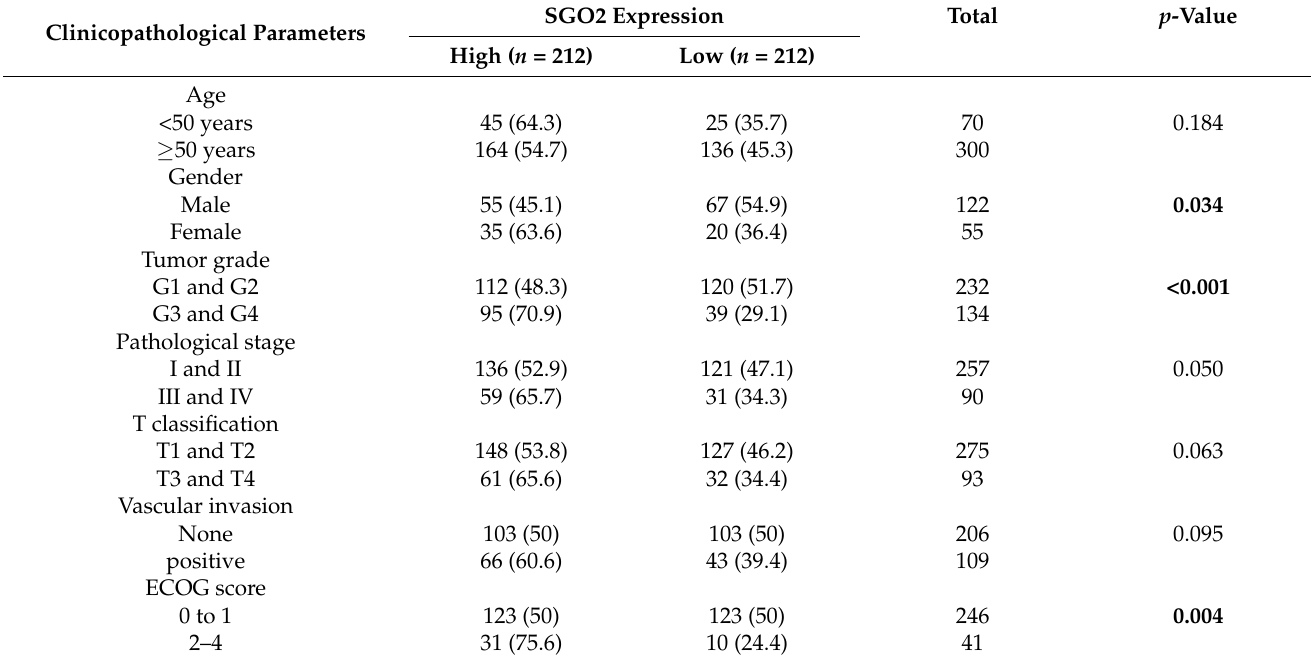
Table 2. Relationships between the SGO2 expression and clinicopathological parameters in HCC.